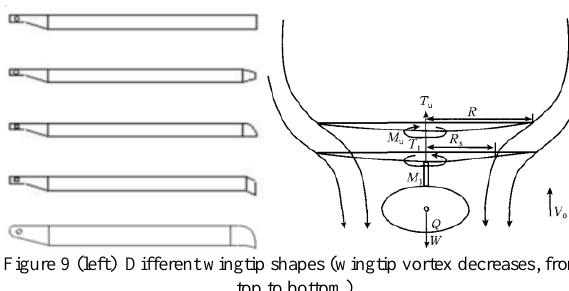
Figure 9 (left) Different wingtip shapes (wingtip vortex decreases, from top to bottom) Figure 10 (right) Diagram of the flow field of coaxial double rotor (cited from reference [4]) Gears are an essential part of a helicopter and have been developed into many mature types, reaching vibration frequencies between those of an engine and the main rotor. Their vibration is mainly caused by the quality of